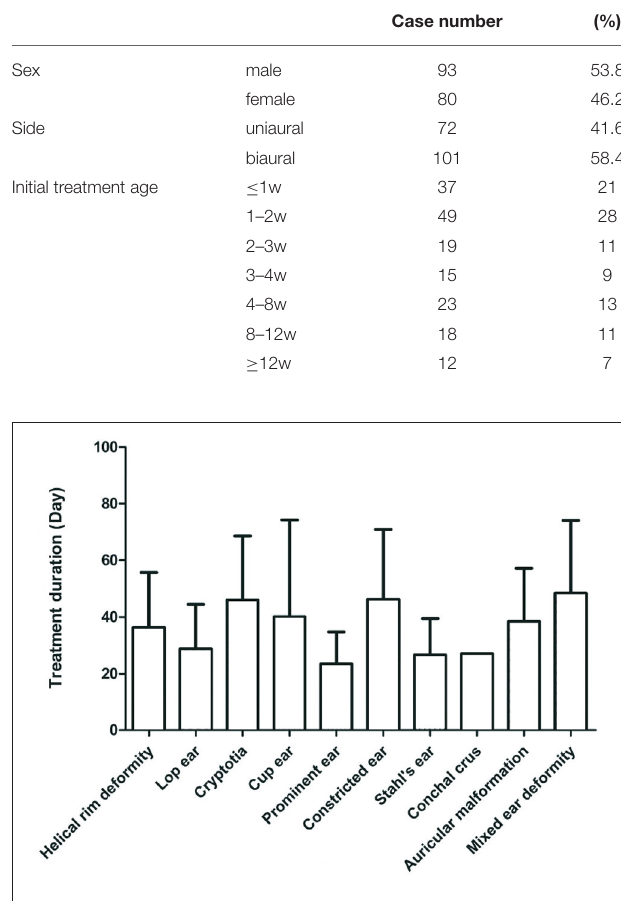
FIGURE 1 | Treatment cycles of different malformation